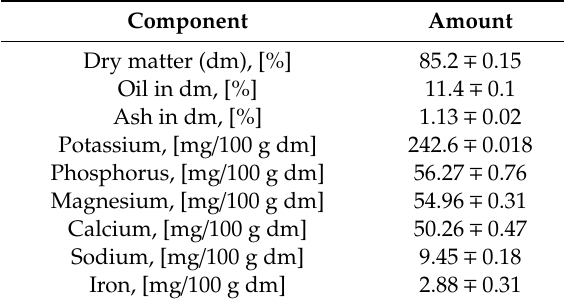
Table 3. Composition of ground date seed.